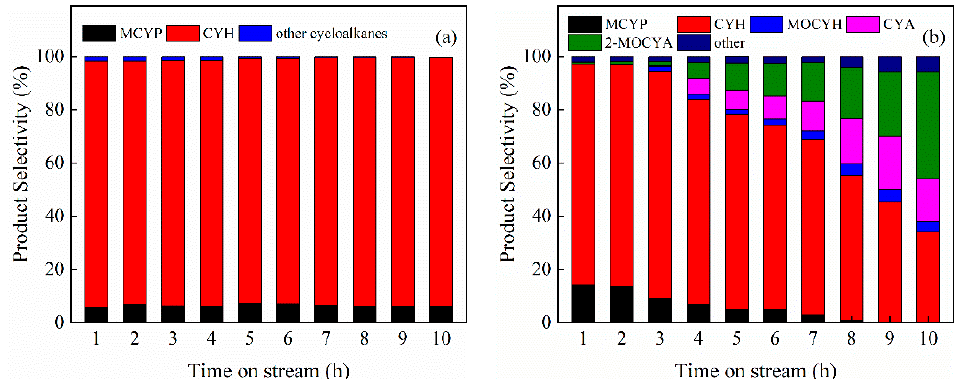
Figure 9. Guaiacol conversion as a function of time on stream over Pt/hZSM-5 and Pt/cZSM-5 catalysts.